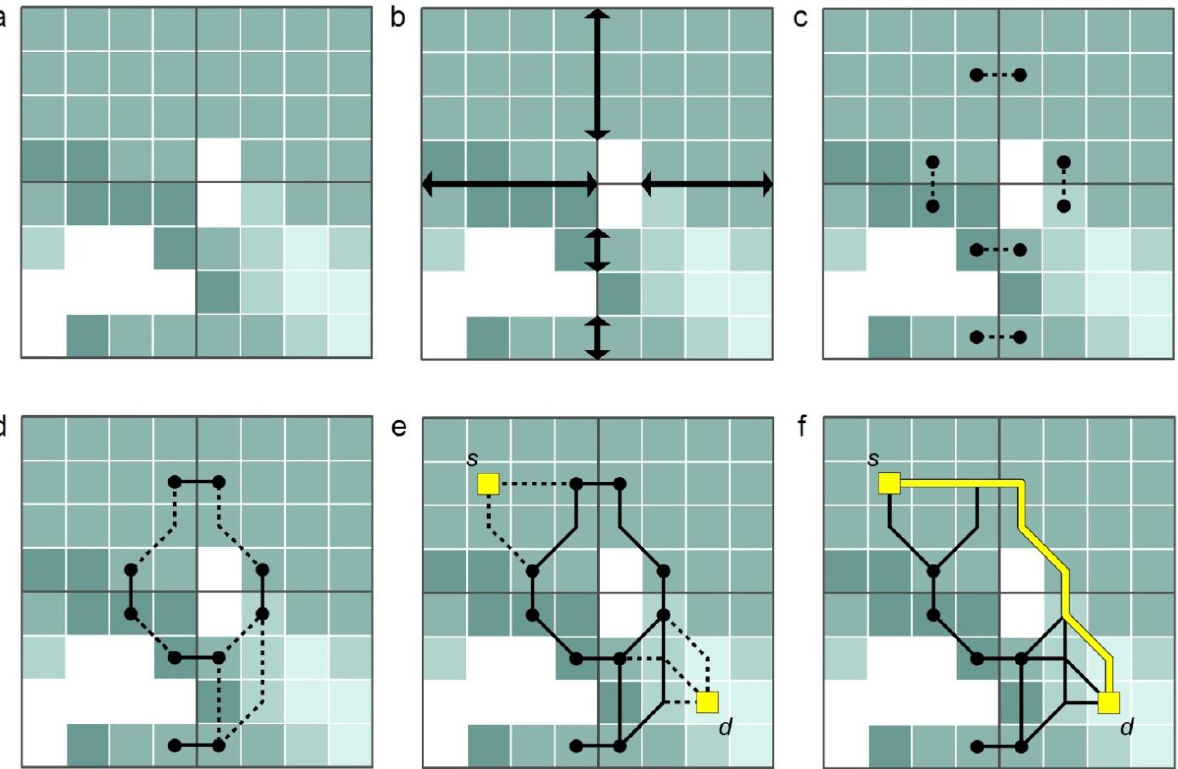
Figure 1. The scheme of the HPA* method: ( a ) dividing the cost raster into blocks, ( b ) identifying the entrances along the block borders, ( c ) determining a transition (inter-edge) to represent each entrance, ( d ) connecting the transition nodes within each block (intra-edges), ( e ) connecting (start) and (destination) temporarily to the graph, and ( f ) finding a path between and